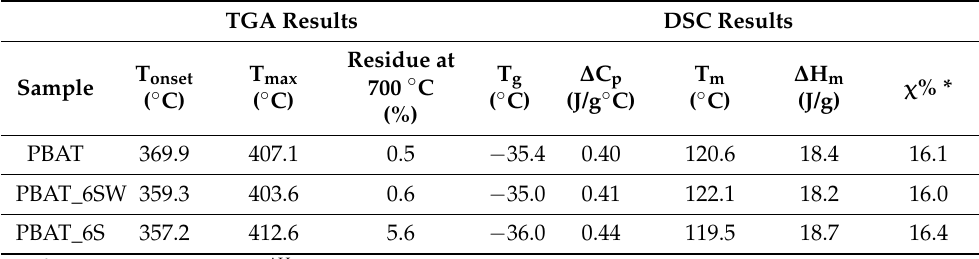
Table 8. TGA and DSC results of PBAT samples.